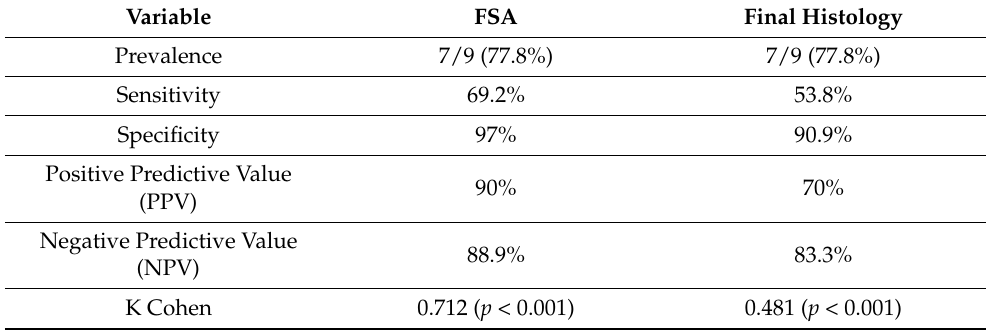
Table 3. Concordance evaluation of FCM at a ureteral level between FSA and final